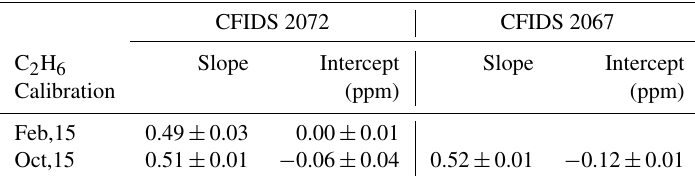
Table 2. Summary of C 2 H 6 calibration factors calculated for both instruments CFIDS 2072 and 2067.